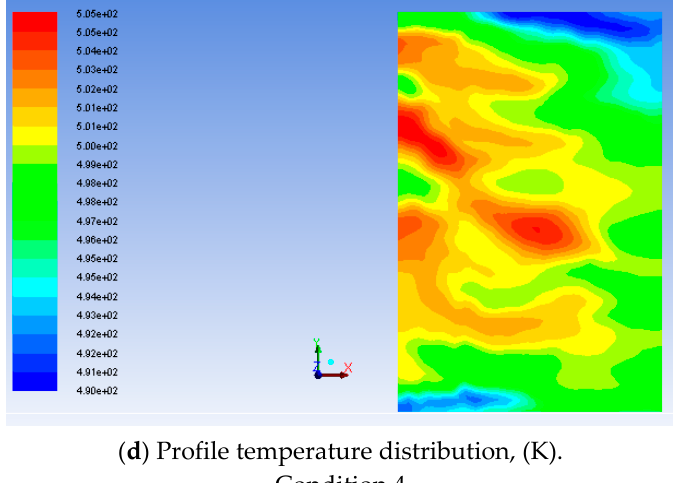
( d ) Profile temperature distribution, (K). Figure 7. Temperature distribution at the upper cross section of the catalyst. ( a ) Condition 1; ( b ) Condition 2; ( c ) Condition 3; ( d ) Condition 4.